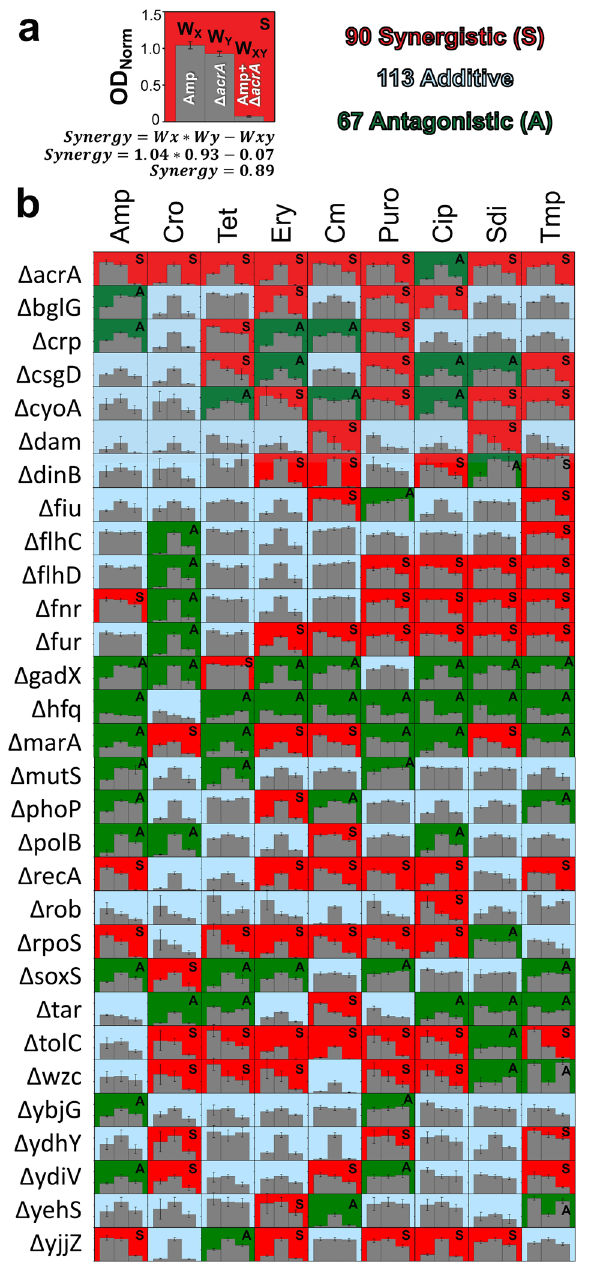
Fig. 1 Synergistic interactions between E. coli BW25113 gene knockouts and drug treatment. a An example of how synergy values were calculated. Strain fi tness ( W ) was calculated as the maximum optical density reached during 16 h of growth, normalized to the maximum optical density of wildtype BW25113 with no antibiotic exposure during the same 16 h growth period. Fitness was calculated in the presence of antibiotic ( W X ), gene knockout ( W Y ), or antibiotic treatment of a gene knockout strain ( W XY ). Synergy (S) was calculated as W X * W Y – W XY , with positive values indicating synergy and negative values indicating antagonism. This example shows that deletion of acrA potentiates antibiotic activity of ampicillin against BW25113. b This process was performed for all 270 gene – drug combinations. Interactions that proved signi fi cantly synergistic (or antagonistic) are color-coded red and have an “ S ” (or green and an “ A ” ). Non-signi fi cant interactions are classed as additive (blue and contain no letter distinction). All bar graphs ’ y -axes use the same scale (from 0.0 to 1.5) used in Fig. 1a. Error bars represent standard deviation of at least three biological